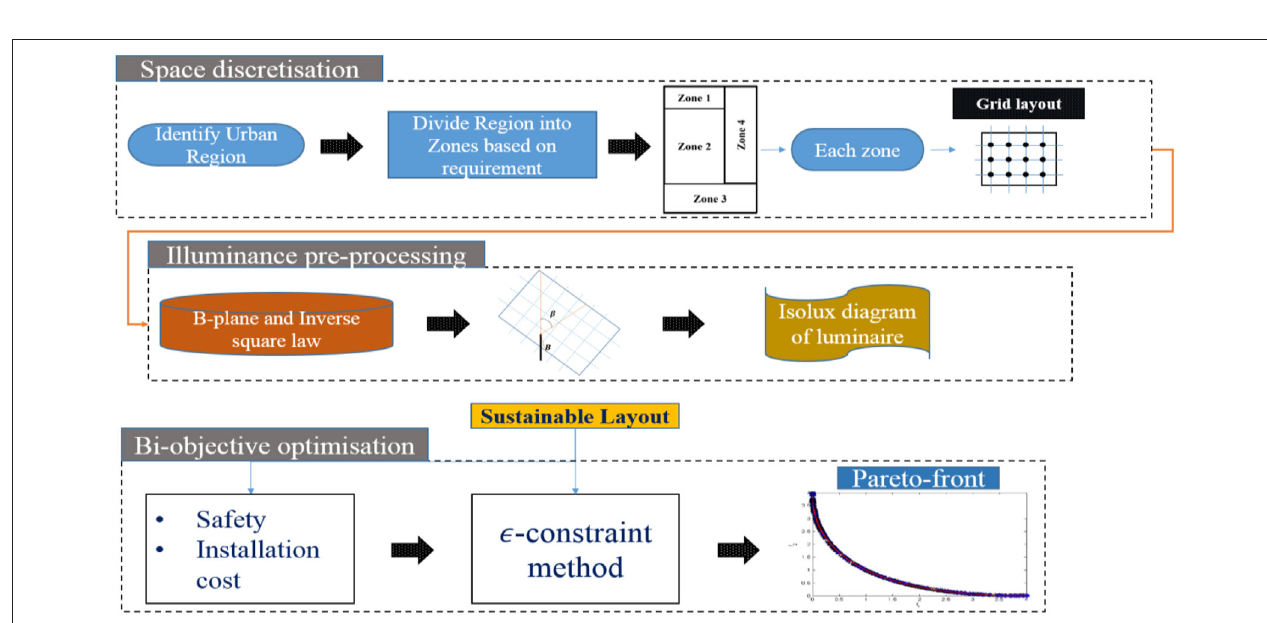
FIGURE 2 | Framework for generating sustainable urban lighting